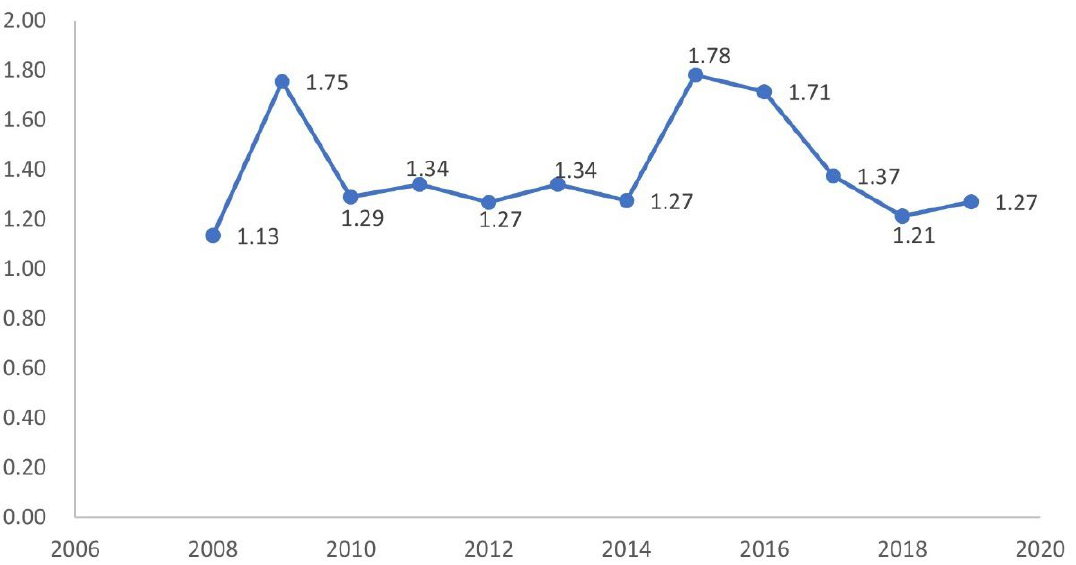
Figure 5. Exchange rate of water footprint value of Tarim River Basin from 2008 to 2019. Data source: According to the statistical yearbook of Xinjiang.